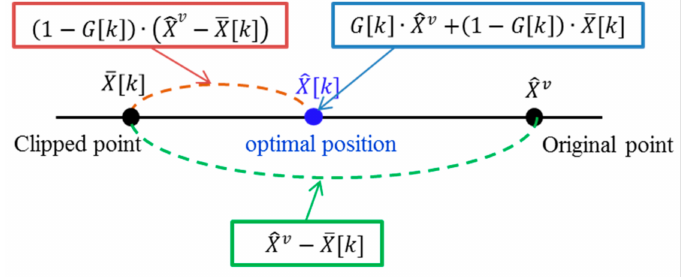
Figure 3. Update procedure with the self-adjustment gain for the constellation point.